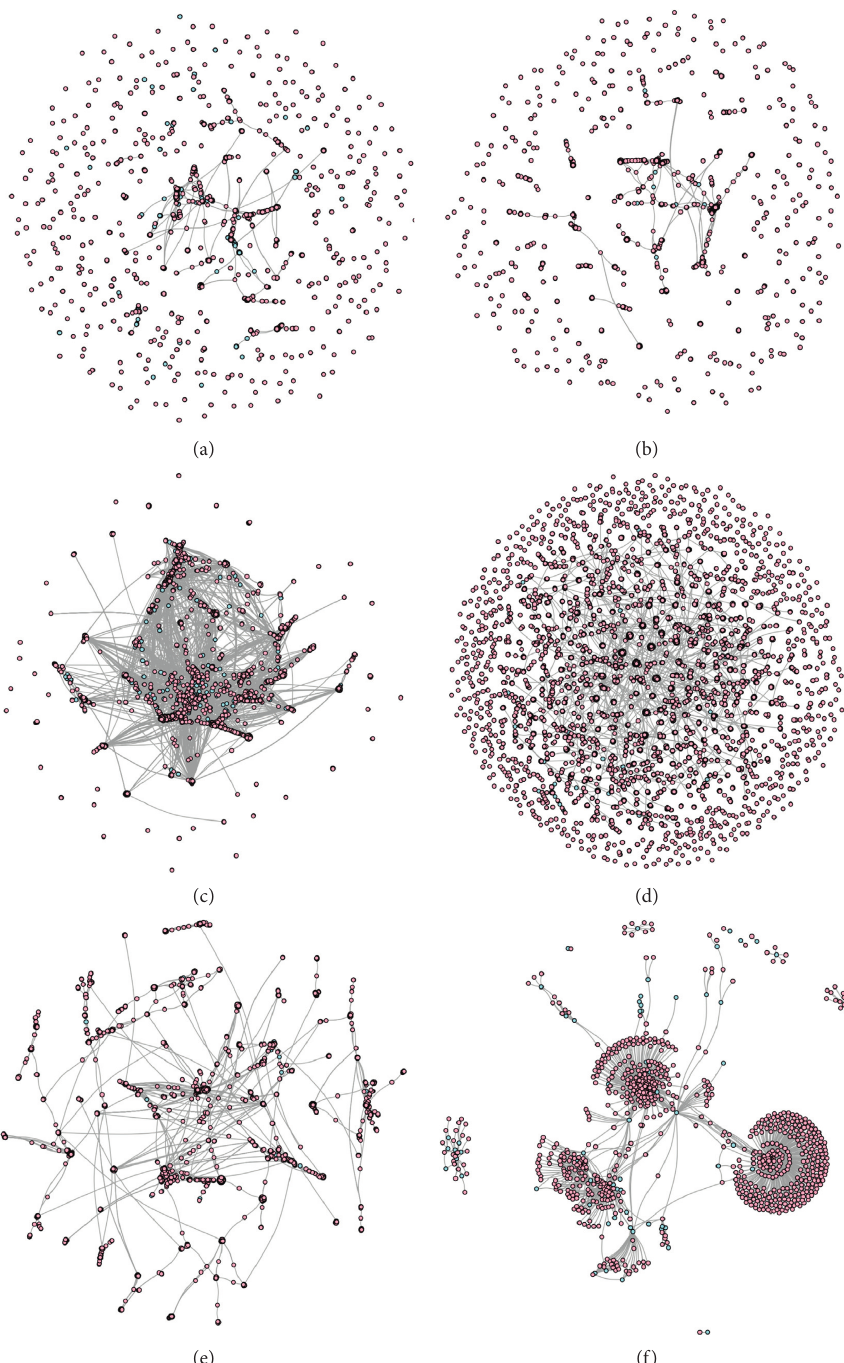
Figure 5: The graphical representation of the extracted skeleton network from different methods: (a) disparity filter, (b) global weight thresholding, (c) k-core decomposition, (d) minimum spanning tree, (e) w-skeleton, and (f)